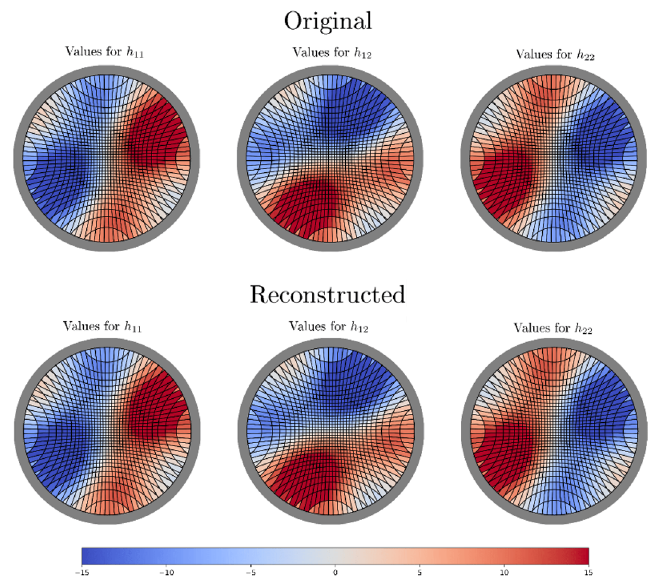
Figure 19. Top: Original bulk data generated with h 0 ( x, y ) = x 2 + y 2 and h | C ( θ ) = 2 cos( θ ) + 3 sin(3 θ ) . Bottom: The bulk data reconstructed after running the forward Radon transform to get boundary data. Visually, the two sets of data are identical. The relative error between the two are E bulk ≈ 0 . 01886 (relative error 0 . 003709 without boundary